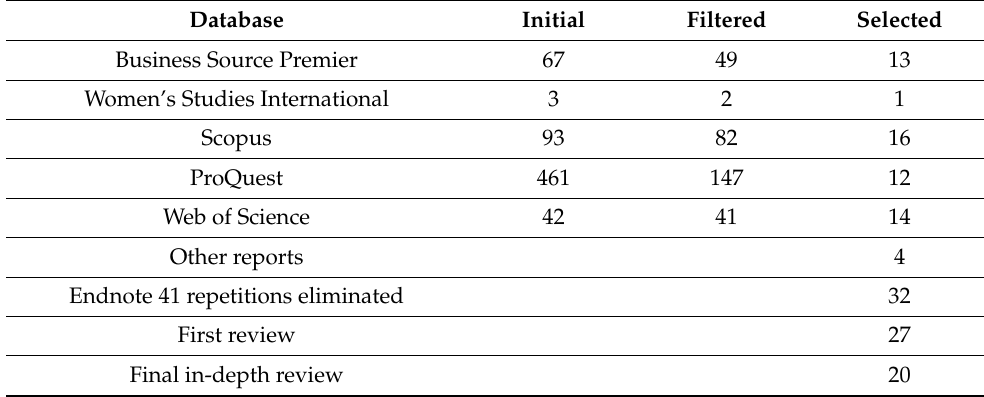
Table 2. Database search results.